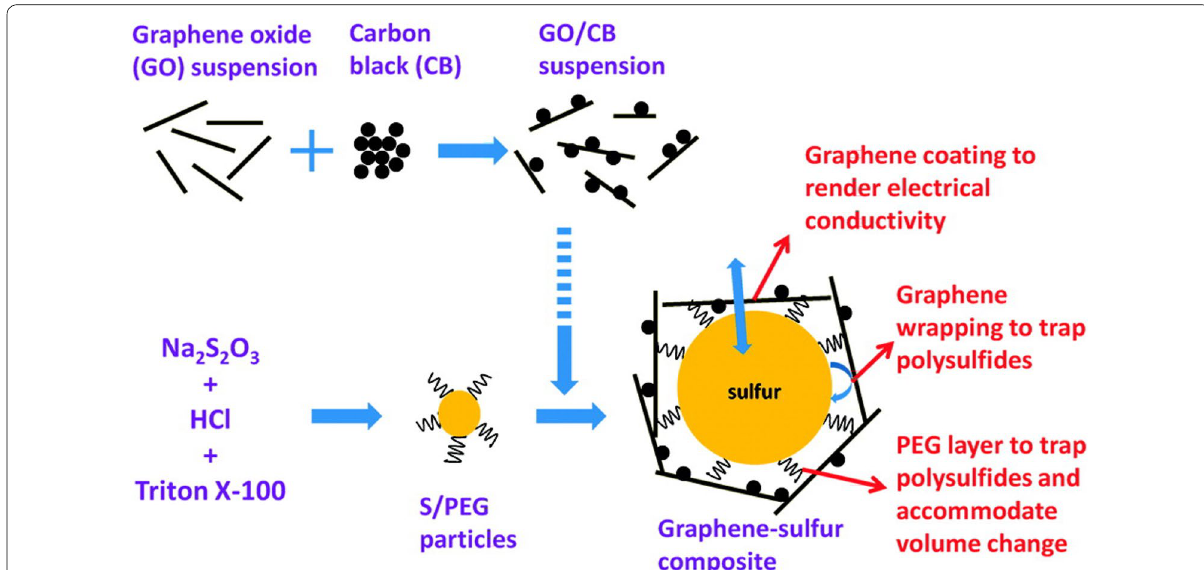
Fig. 9 Schematic of the synthesis steps for a graphene‑sulfur composite, with a proposed schematic structure of the composite (Reprinted with permission